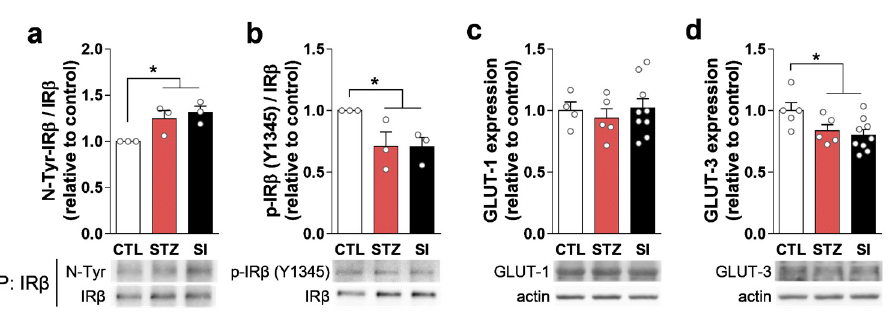
Figure 10. Hyperglycemia increased IR β tyrosine nitration and decreased IR β phosphorylation and glucose transporter (GLUT) expression. ( a , b ) Immunoprecipitation (IP) of IR β and subsequent Western blot of ( a ) nitrotyrosine (N-Tyr) and ( b ) phospho-IR β (Y1345). n = 3/group (three replicative IPs with pooled lysates). ( c , d ) Western blots of ( c ) GLUT-1 and ( d ) GLUT-3 in the PFC. CTL, n = 5; STZ, n = 5; SI, n = 9. Data are presented as mean ± SEM. * p < 0.05 between indicated groups according to one-way ANOVA with Newman–Keuls post-hoc tests.